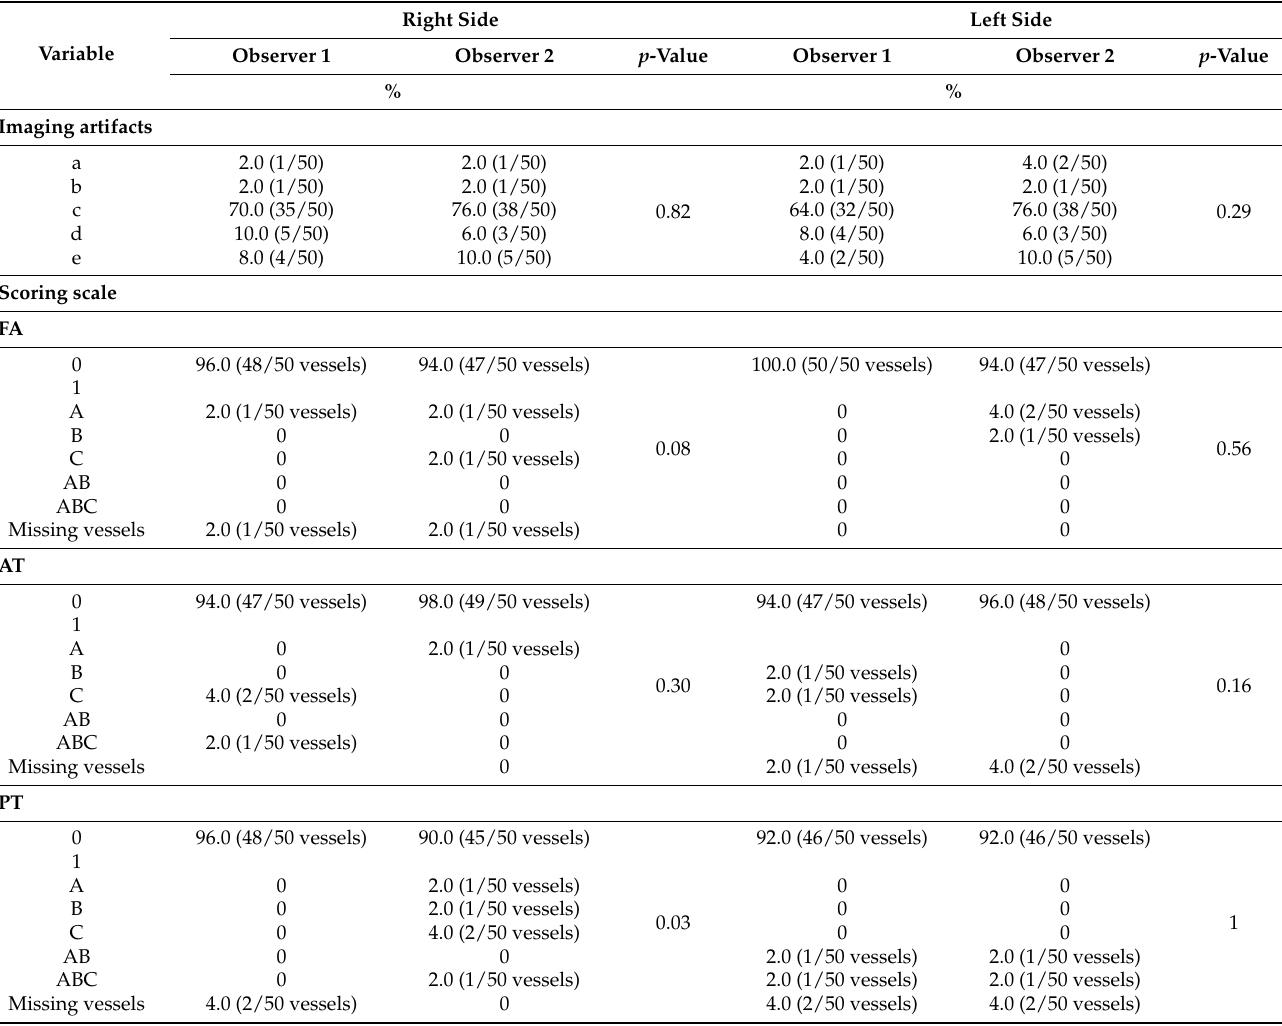
Table 4. Evaluation of imaging artifacts and the presence or absence of stenosis in the fibular artery (FA), anterior tibial artery (AT), and posterior tibial artery (PT) in the lower right and left legs by two observers; p -values were determined using the Wilcoxon signed-rank